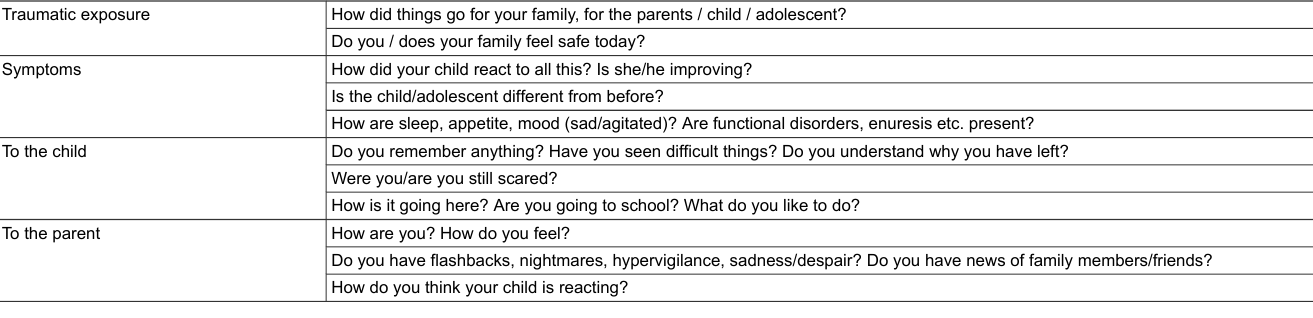
Table 5: Potential questions to guide discussion on mental health. Traumatic exposure How did things go for your family, for the parents / child /